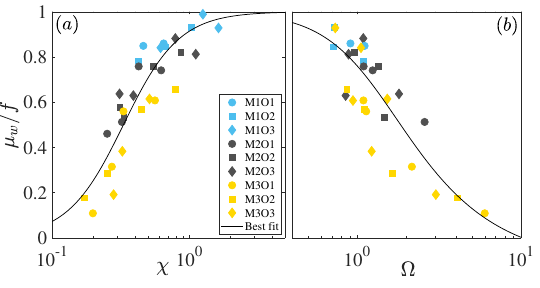
Figure 4. Experimental data of ( a ) µ w / f − χ and ( b ) µ w / f − Ω . The solid lines denote the best fitting curve for each corresponding model of Eq. (1) and (2),